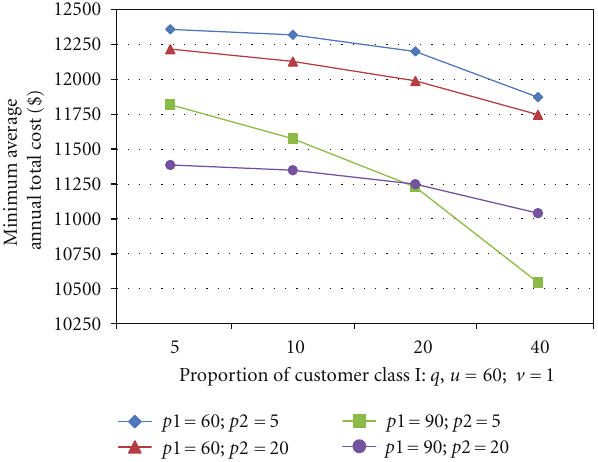
Figure 8: The impact of customer di ff erentiation on ATC under the disruption scenario of { u = 60; v = l }